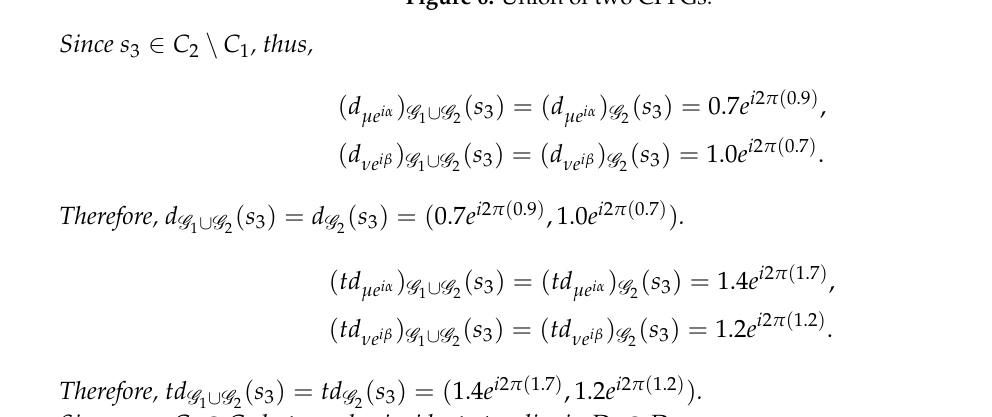
Figure 6. Union of two